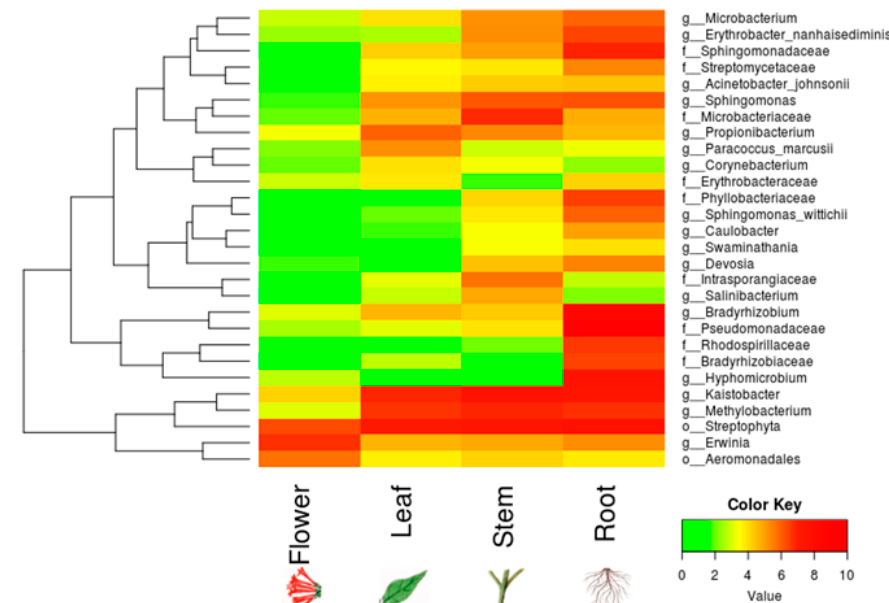
Figure 4. Core endophyte microbiota in different anatomical parts of B. ternifolia. The heatmap shows the absolute abundance of bacterial taxa for endophytes in the flowers, leaves, stems and roots. Included counts for each taxon in the analysis were present in at least 50% of the samples. Color key from green to red indicates increasing absolute abundance in natural logarithm of counts. Green color indicates the lowest abundance while red color the highest